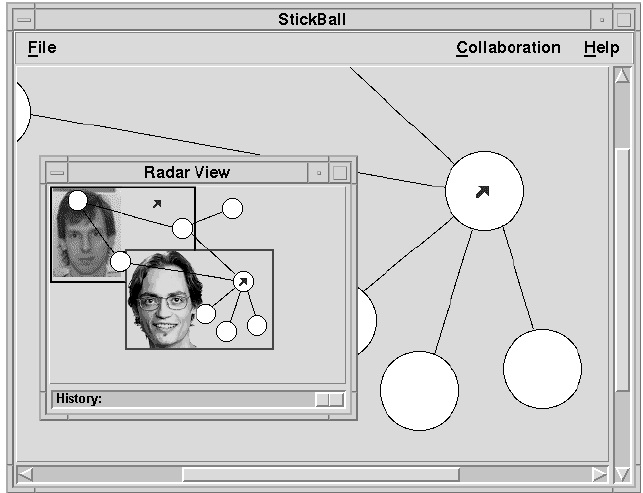
Figure 15. Spatial and semantic network guideline.